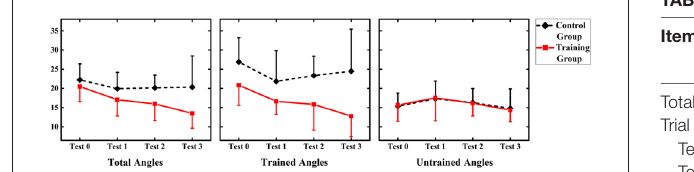
TABLE 1 | Result of test-retest reliability analyses for control group.